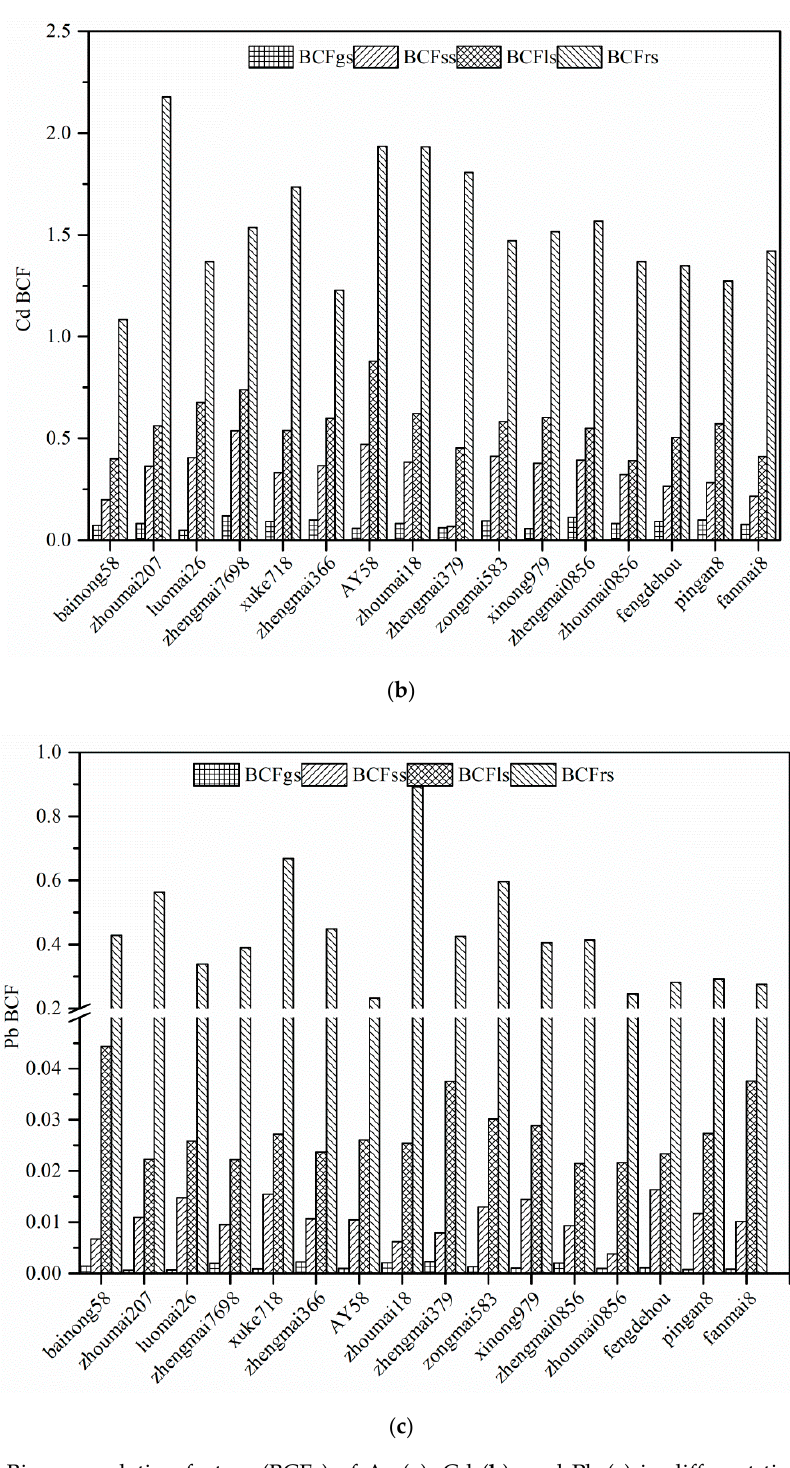
Figure 3. Bioaccumulation factors (BCFs) of As ( a ), Cd ( b ), and Pb ( c ) in different tissues of the 16 wheat cultivars.